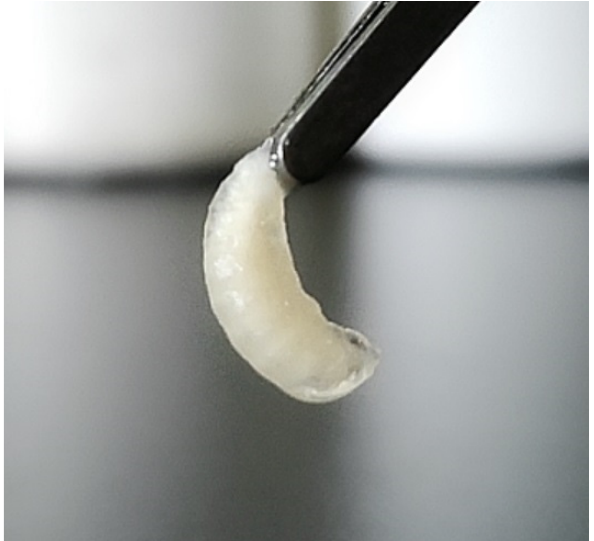
Figure 1. Sacbrood disease of an Apis cerana larva (photograph by Xiaoqing